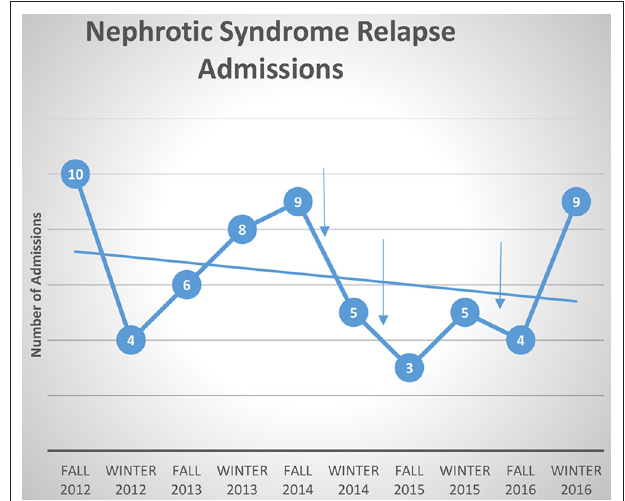
FIGURE 2 | Admissions for nephrotic syndrome relapse over 5 years. Each arrow indicates time of PDSA cycle. Best fit line shows general trend toward decreasing number of admissions.